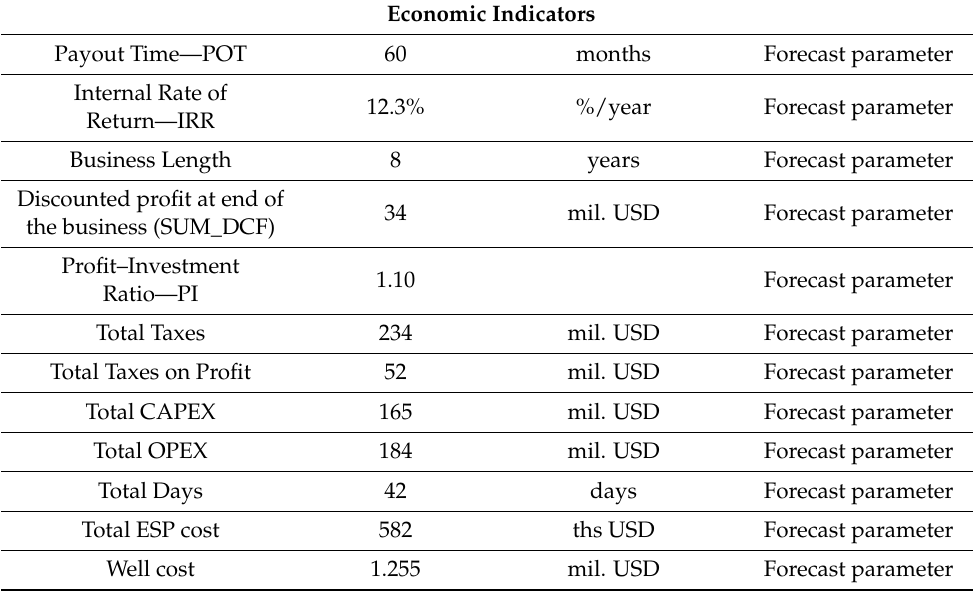
Table 7. Table with Forecast Variables—Alternate Field Development Strategy.